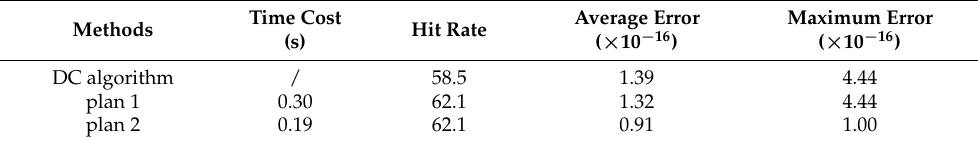
Table 1. Comparison of deflation detecting methods (average of 20 2001 × 2001 matrices).